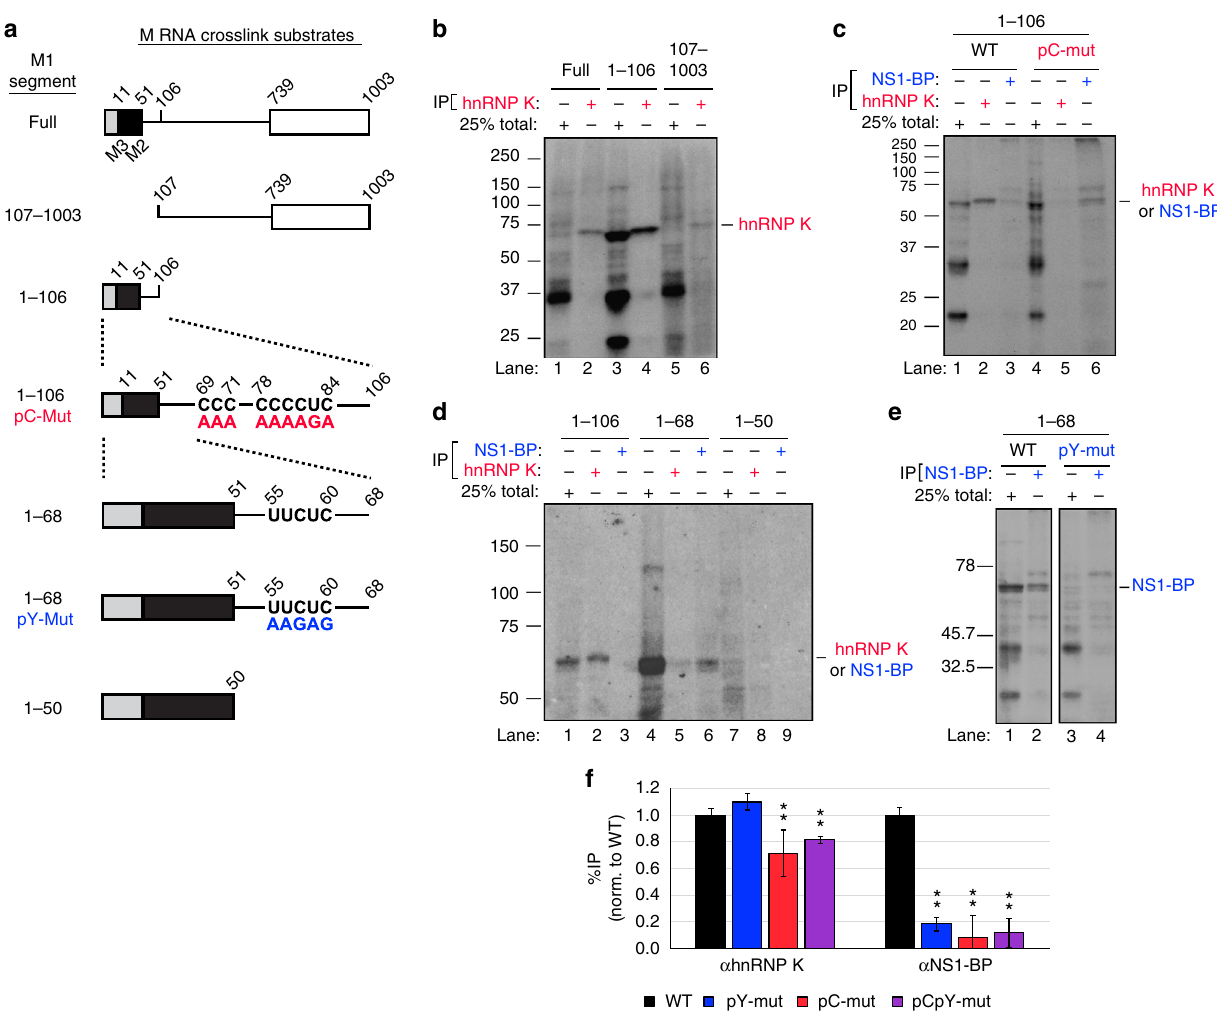
Fig. 2 hnRNP K and NS1-BP bind adjacent sequences downstream of M2 5 ′ ss. a Diagrams of M segment-derived RNA substrates used for UV-crosslinking assays. Names of each probe are indicated on the left. Boxes denote exons and the lines denote introns. Mutations of WT nucleotides are in color with hnRNP K associated mutations in red and NS1-BP associated mutations in blue. b UV-crosslinking of probes: Full, 1 – 106, and 107 – 1003. IP for hnRNP K. For total lanes 25% of the reaction was loaded. For IP lanes, indicated proteins were immunoprecipitated from RNase-treated cross-link reactions via primary antibody and 100% of bead eluate was loaded. Sizes of immunoprecipitated cross-link species are indicated on the right of the gel image. c UV-crosslinking of probes: 1 – 106 and 1 – 106 pC-mut. IP for hnRNP K and NS1-BP. d UV-crosslinking of probes: 1 – 106, 1 – 68, and 1 – 50. IP for hnRNP K and NS1-BP. e UV-crosslinking of probes: 1 – 68 and 1 – 68 pY-mut. IP for NS1-BP. f CLIP-PCR of full-length M segment probes cross-linked in nuclear extract